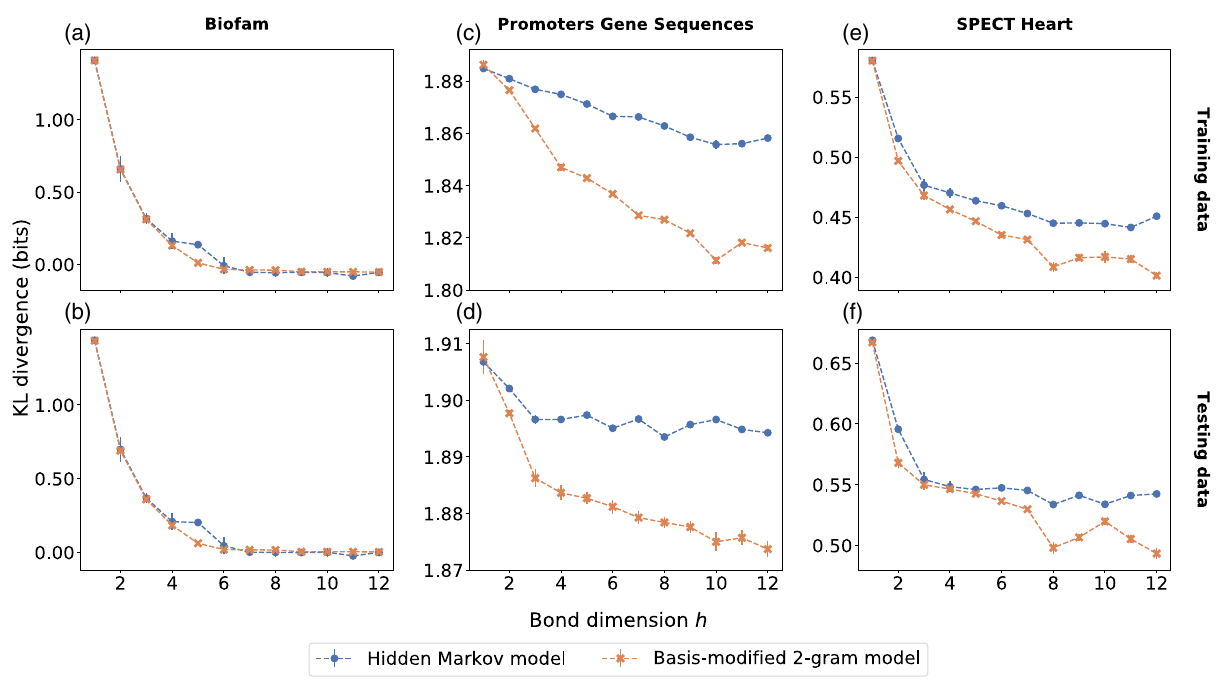
FIG. 7. Best performances over ten trials of the classical HMM (blue circles) and the basis-enhanced 2-gram model (orange crosses) on the (a,b) biofam, (c,d) Promoter Gene Sequences, and (e,f) SPECT Heart data sets. The first row plots the performance on the training data, and the second the performance on withheld testing data. The basis-enhanced 2-gram models have better performance than classical HMMs on the SPECT Heart and Promoter Gene Sequence data sets. Error bars denote 1 standard error of the mean over ten trials. Dashed lines are to aid the eye.